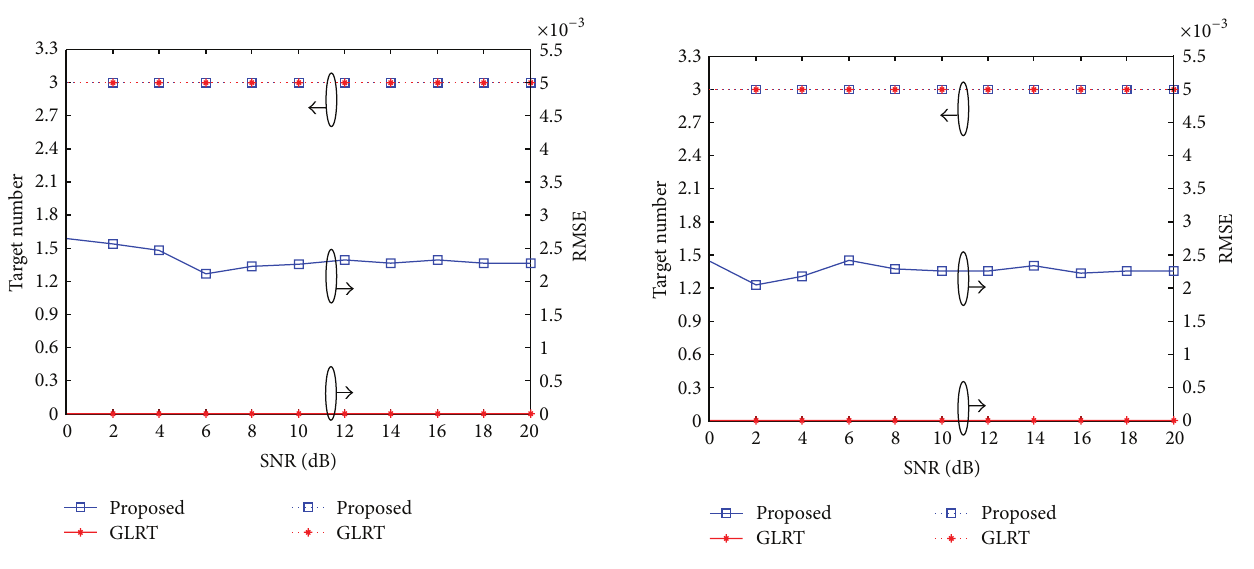
Figure 7: RMSE and the number of estimated SOIs, in case C.